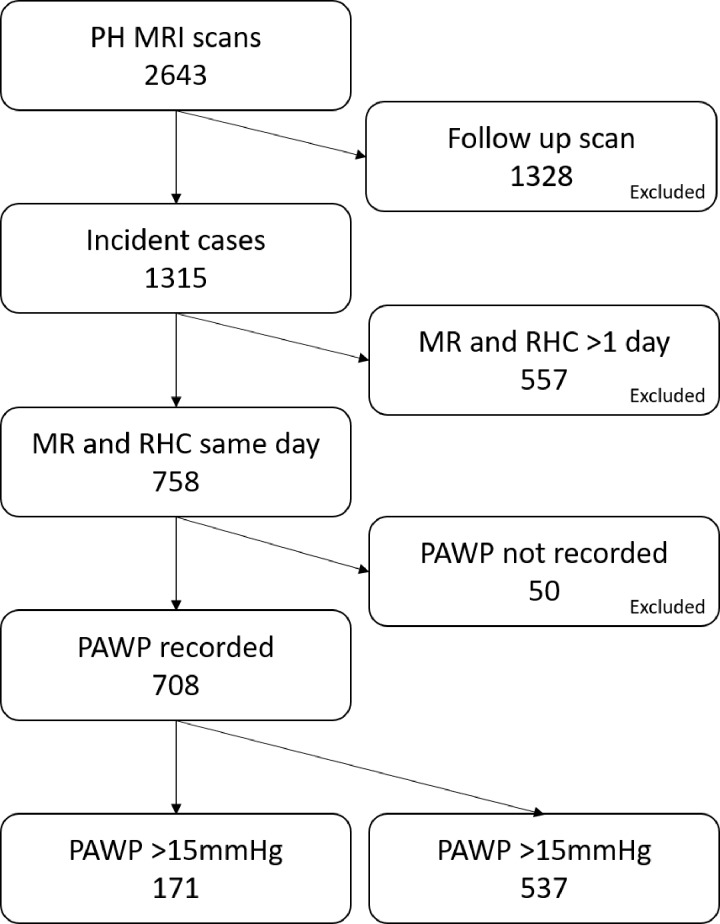
Flowchart shows patient inclusion criteria. PAWP =
pulmonary artery wedge pressure, PH = pulmonary
hypertension, RHC = right-sided heart
catheterization.